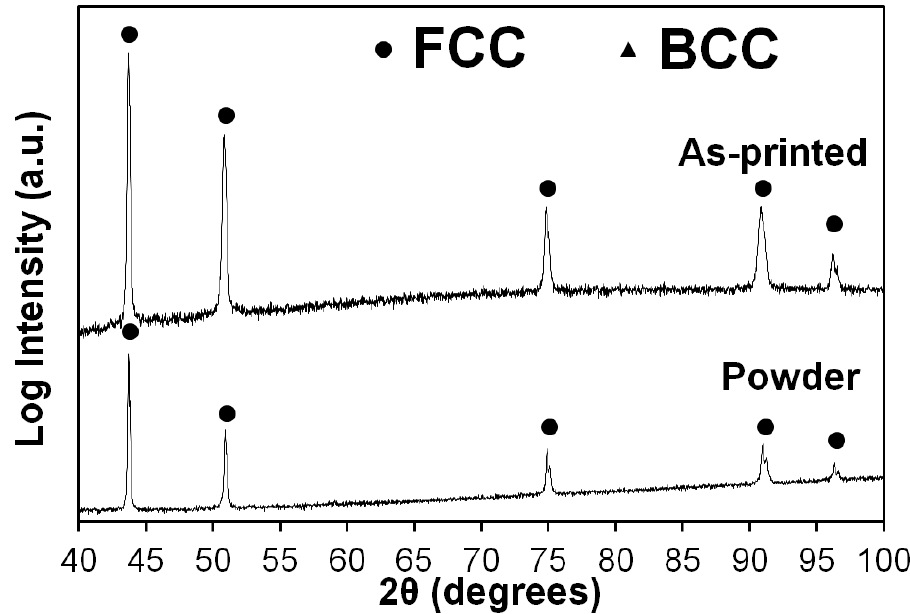
Figure 5. X-ray diffraction patterns of powder and as-printed Fe 65 (CoNi) 25 Cr 9.5 C 0.5 alloy. Figure 5. X-ray di ff raction pa tt erns of powder and as-printed Fe 65 (CoNi) 25 Cr 9.5 C 0.5 alloy.